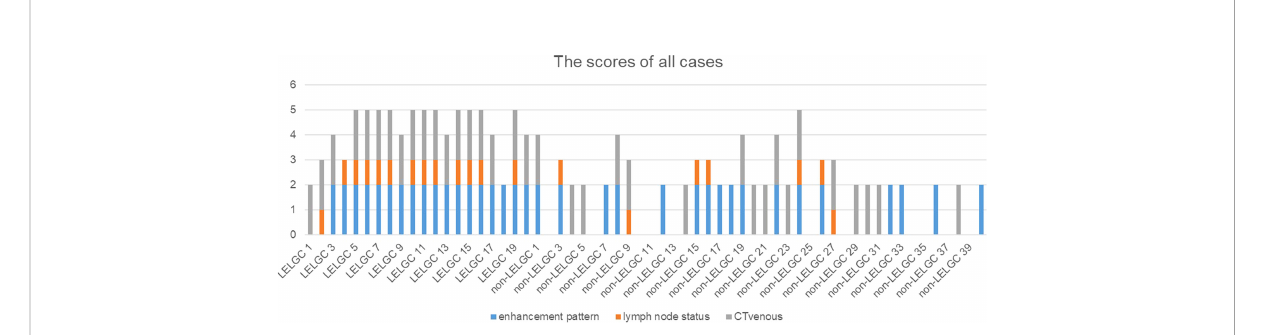
FIGURE 4 The preoperative risk scores of patients in the training cohort. The total scores of patients with lymphoepithelioma-like gastric carcinoma (LELGC) were higher than that of patients with